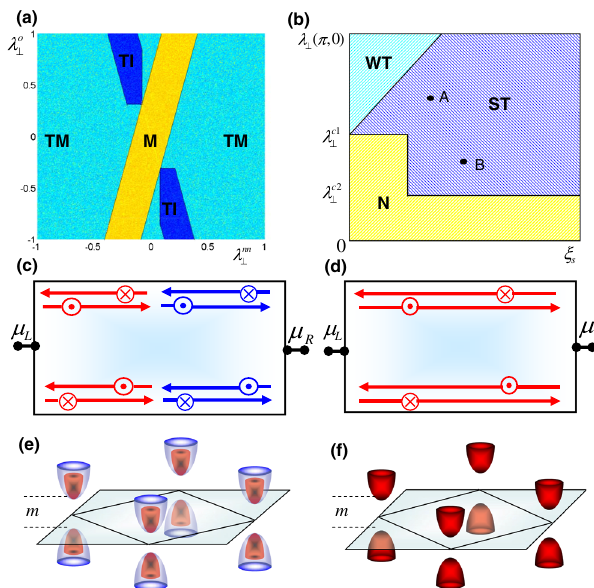
FIG. 5. (a) The phase diagram as a function of λ o ⊥ and λ nn ⊥ . Here, M, TM, and TI label metallic, topologically metallic, and topologically insulating phases, respectively. (b) The phase diagram as a function of λ ⊥ ð π ; 0 Þ and ξ for λ ⊥ ð π ; 0 Þ > 0 . Here, s WI, ST, and N label weak topological, strong topological, and normally trivial phases, respectively. “ (c),(d) ” The picture of the accumulation of spin currents in the weak and strong topological insulating phases of SL FeSe with the rectangle geometry. Here, “ ⊗ ” / “ ⊙ ” labels the majority of spin-up and spin-down compo- nents. The color corresponds to Fig. 3(i) and Fig. 4(d2) and 4(h2). (e) The two nontrivial (trivial) Dirac cones with negative (positive) mass m correspond to Fig. 4(a1) [Fig. 4(e1)] around M points in BZ. Red and blue label the Dirac cone structures with even and odd parities, respectively. (f) The single nontrivial Dirac cone with negative mass m [Figs. 4(c1) and 4(g1)] around M points in